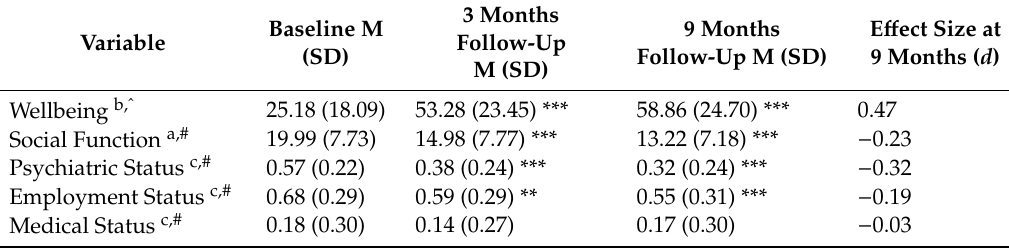
Table 3. Baseline ( n = 166), 3 months ( n = 157) and 9 months ( n = 150) follow-up biopsychosocial